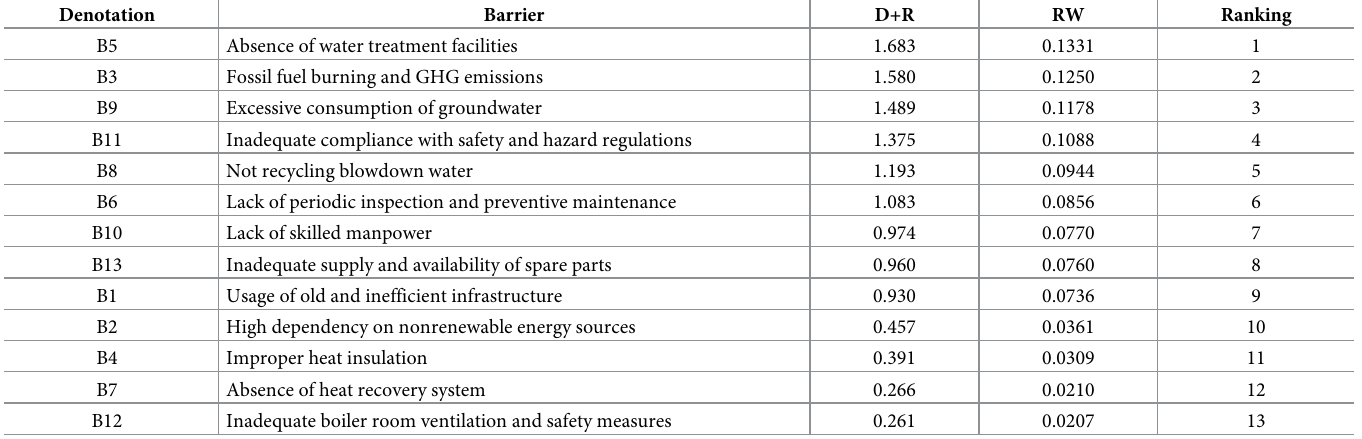
Table 4. Prominence ranking of the barriers to sustainable boiler operation.